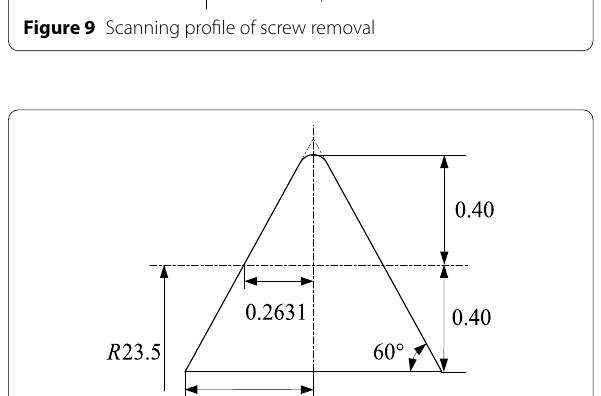
Figure 9 Scanning profile of screw removal